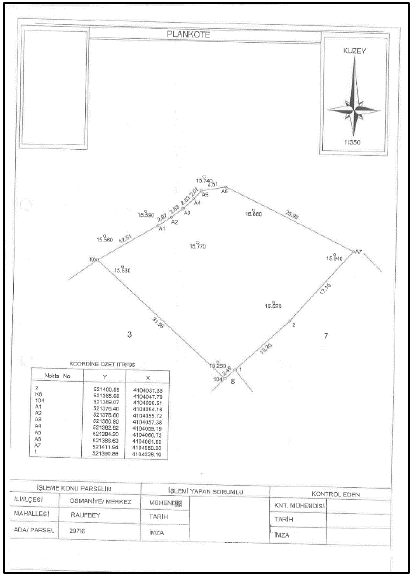
Figure 4. Plankote (sample form Osmaniye City in